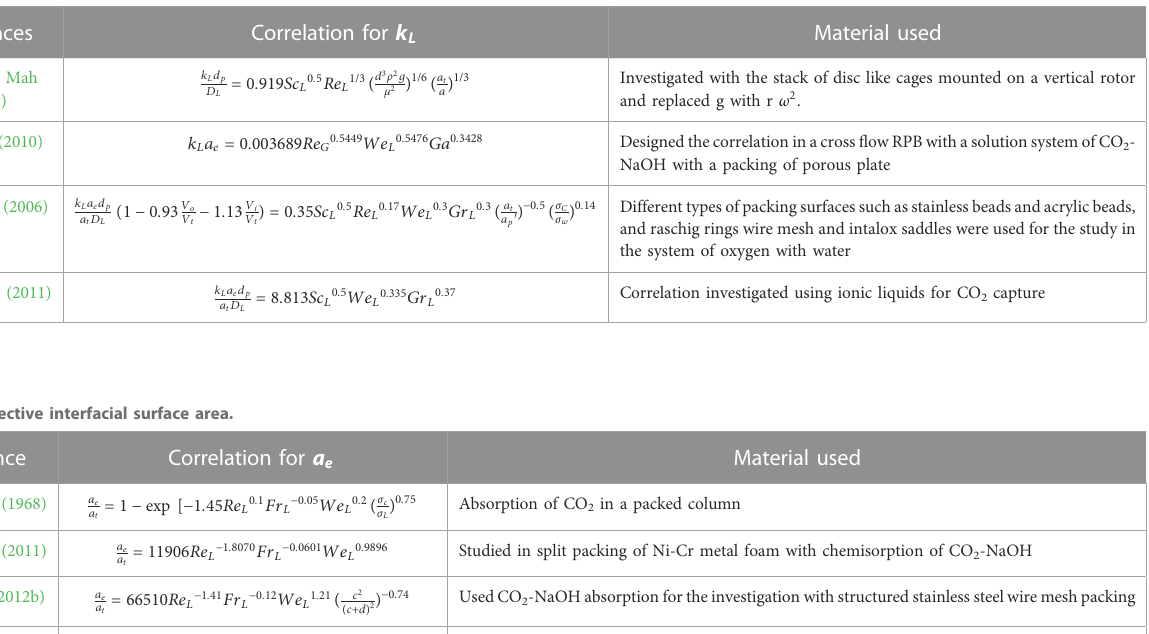
TABLE 5 Liquid phase mass transfer coef fi cient correlation in RPB.